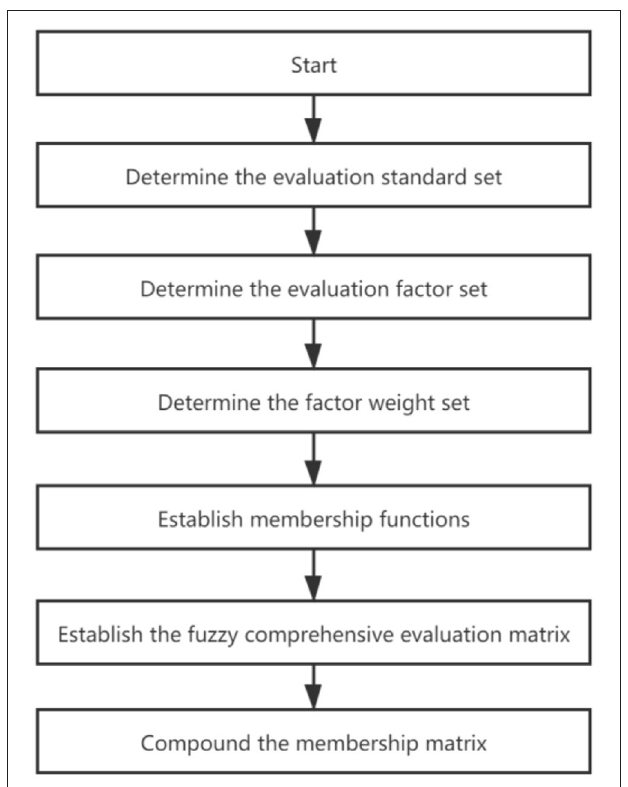
FIGURE 3 | Schematic of fuzzy comprehensive evaluation for indoor air